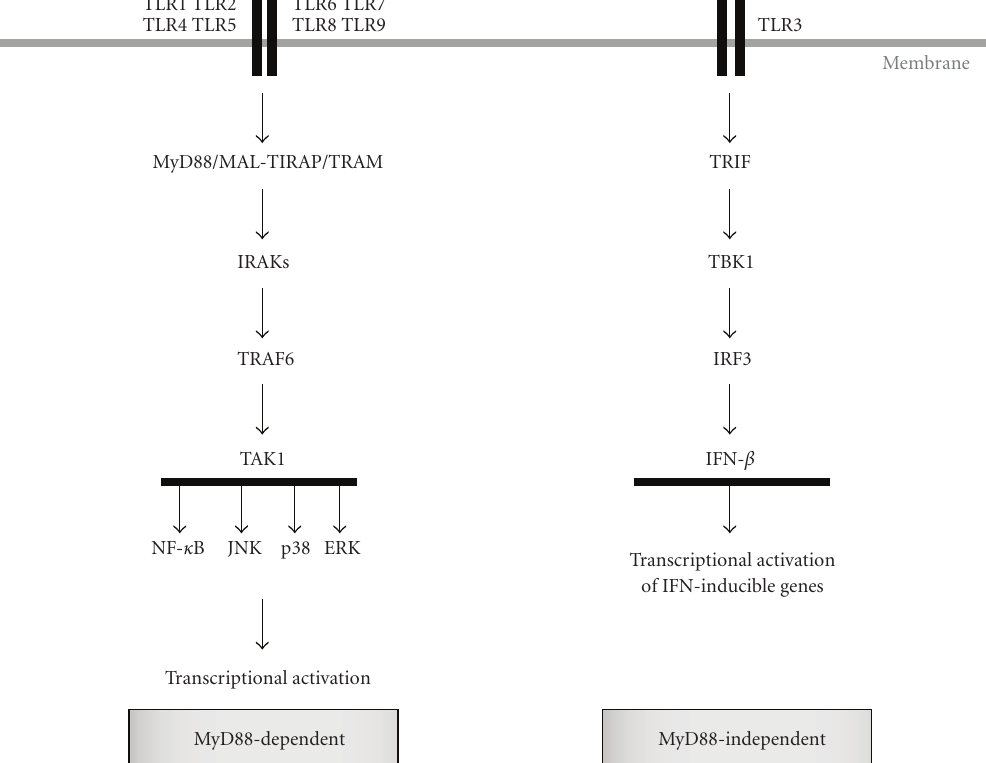
Figure 1: TLR signalling. Ligand recognition results in the recruitment of intracellular TIR-domain-containing adaptors proteins, including myeloid-di ff erentiation primary-response protein 88 (MyD88, shared by all TLRs, except TLR3), and Toll/IL-1R domain-containing adaptor- inducing IFN- β (TRIF, employed by TLR3 and TLR4). Engagement of MyD88 activates a signaling cascade including IL-1R-associated kinases (IRAKs,), (TNF)-receptor-associated factor 6 (TRAF6) and transforming growth factor- β (TGF- β )-activated kinase (TAK1), leading to the activation of the mitogen-activated protein (MAP) kinases ERK, JNK, and p38, and nuclear translocation of the transcription factor nuclear factor- κ B (NF- κ B) (MyD88-dependent pathway). There is a second, alternative pathway triggered by TRIF (MyD88-independent pathway) that culminates in the activation of NF- κ B, MAPKs, and the transcription factors interferon-responsive factors (IRFs), whose are responsible for induction of type I IFNs, in particular IFN β . Besides MyD88 and TRIF, two other adaptor proteins have been described: TIR- domain-containing adaptor protein (TIRAP, also called MAL), and TRIF-related adaptor molecule (TRAM, required for TRIF-dependent signaling through TLR4, but not